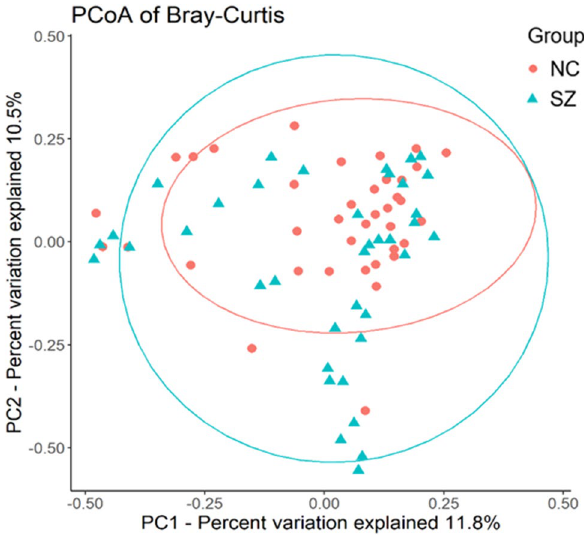
Figure 1. PCoA plot illustrating beta diversity distance matrices of the Bray–Curtis distance comparing the sample distribution between the two groups. The red dots represent NCs, and the green triangles represent SZ.